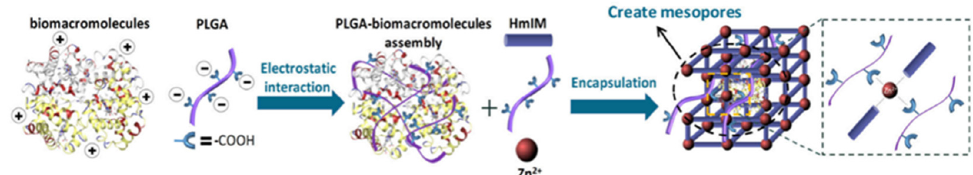
Figure 31. Diagram of the in situ encapsulation of biomolecules in transmutable MOFs by PLGA modulation (reproduced with permission of John Wiley & Sons, Inc. from ref. [114]).